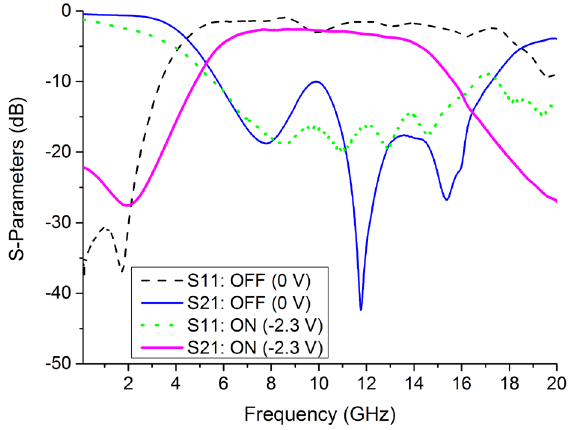
Figure 18. Measured results of the 10 GHz filter in both states.